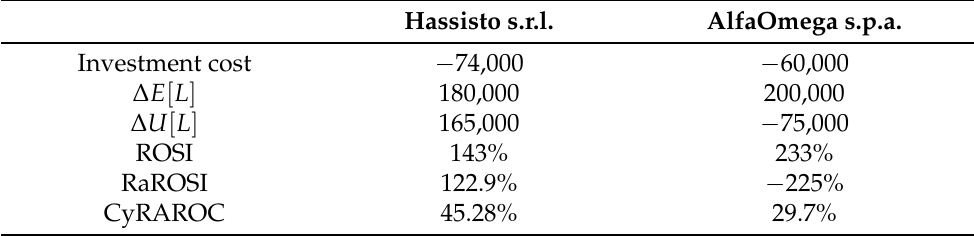
Table 1. Security investment metric results for Hassisto s.r.l. and AlfaOmega s.p.a. i = 0.15. Hassisto